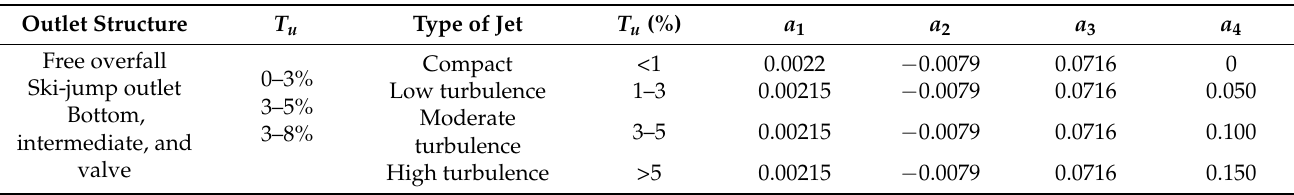
Table 7. The range of T u due to the type of outlet structure (left side) [61]; polynomial and regression coefficients for various T u (right side) [62].